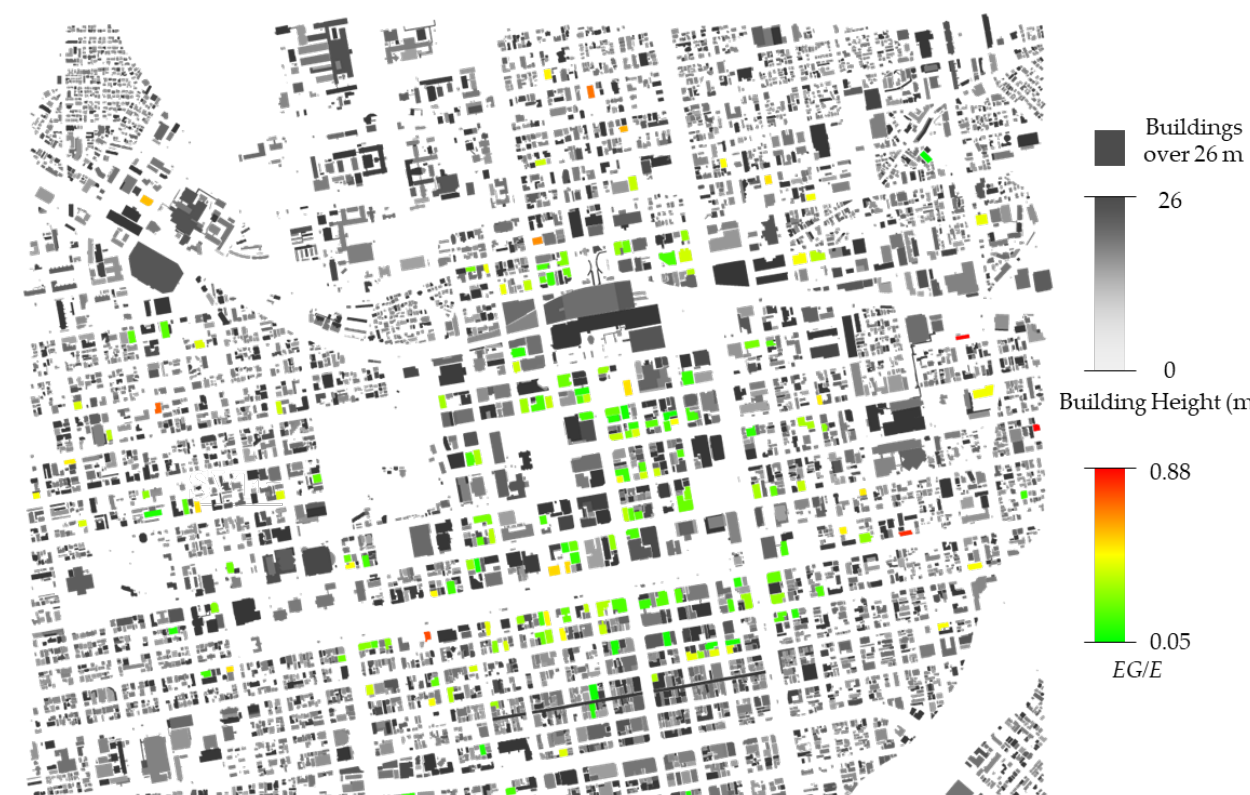
Figure 13. Distribution of 𝐸𝐺/𝐸 (OW1, WQ1, Case-1).